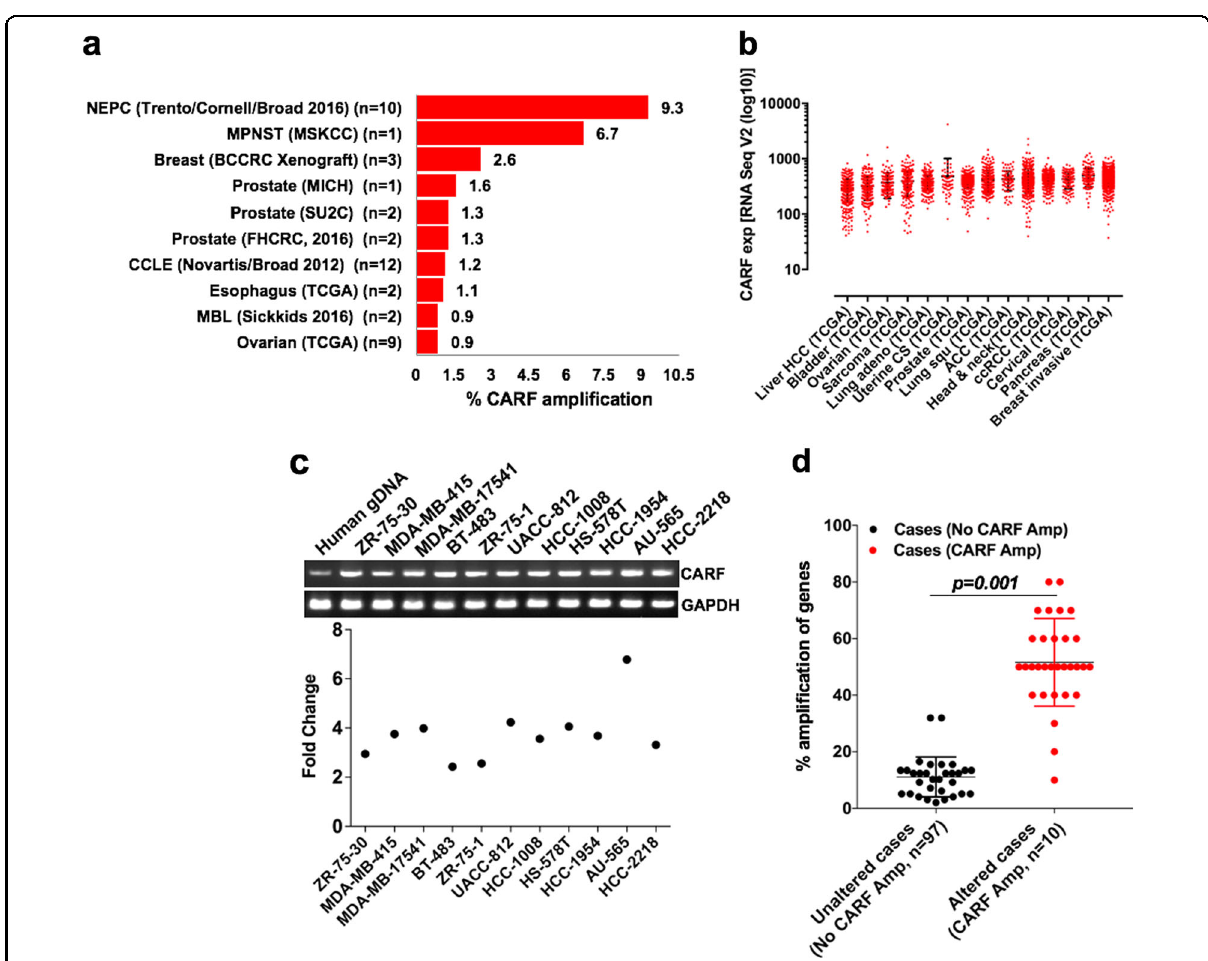
Fig. 1 Ampli fi cation of CARF and its enrichment in metastatic malignancies. a Percentage CARF ampli fi cation in clinical cancer datasets in TCGA database. b Enrichment of CARF mRNA levels in invasive and metastatic malignancies; RNA-Seq (V2 algorithm) expressions in log10 scale. c CARF- gene ampli fi cation in metastatic breast cancer cell lines (upper); values represented as fold enrichment (lower). d Dot plot showing percentage ampli fi cation of candidate genes (shortlisted in TCGA-de fi ned invasion/metastases and angiogenesis gene sets) in patients with ( n = 10) and without ( n = 97) CARF ampli fi cation in NEPC (2016)